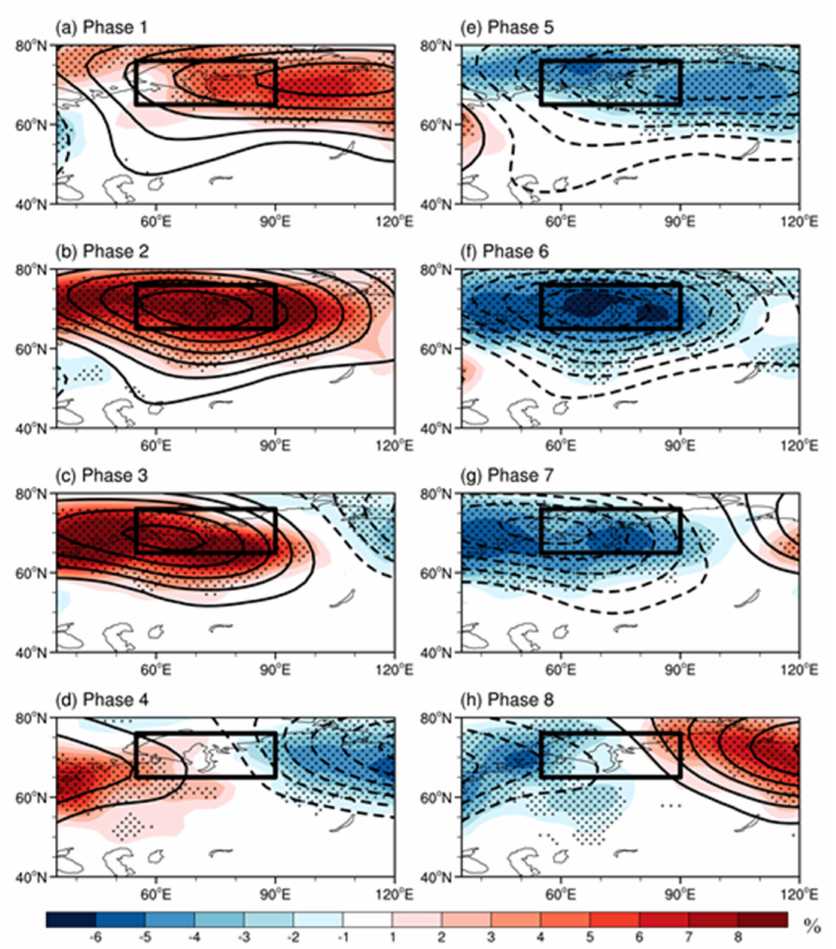
Figure 6. ( a ) Horizontal distribution of blocking frequency anomalies (shading; unit: %) and 10–30- day − filtered 500 hPa geopotential height anomaly (contour interval: 10 gpm; zero line omitted) at Phase 1 during westward − propagating mode. ( b − h ) As in ( a ) but for Phase 2 to Phase 8, respectively; the black boxed region indicates the key area, and dotted area indicates the anomalies exceeding the 0.05 significance